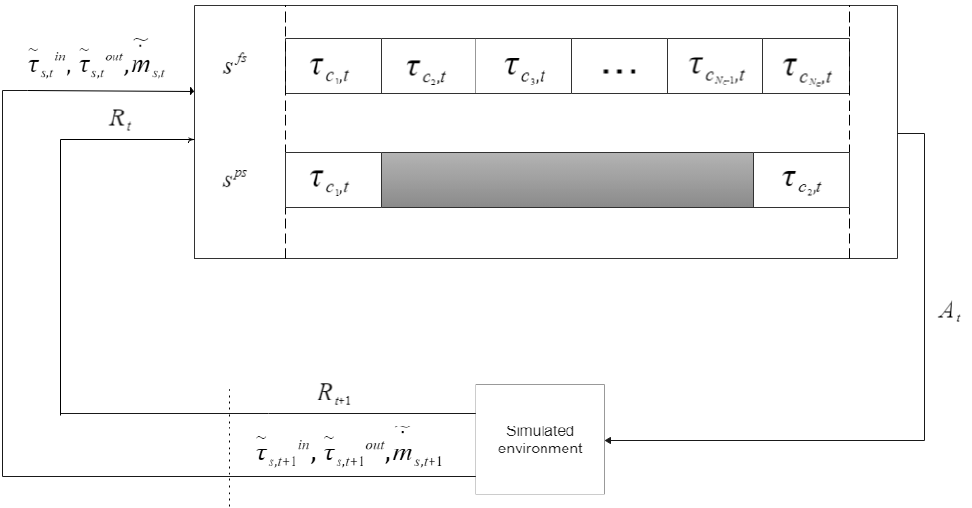
Figure 2. The reinforcement learning (RL) agent–simulation environment interaction. Based on the RL agent’s action at the time-step t , A t , the simulation environment at the time-step t ` 1 outputs observations of the supply network inlet temperature r τ in , supply network outlet temperature s , t ` 1 r r τ out 9 m s , t ` 1 , and reward R t ` 1 . These observations form a Q -learning full s fs and and mass flow s , t ` 1 partial state s ps